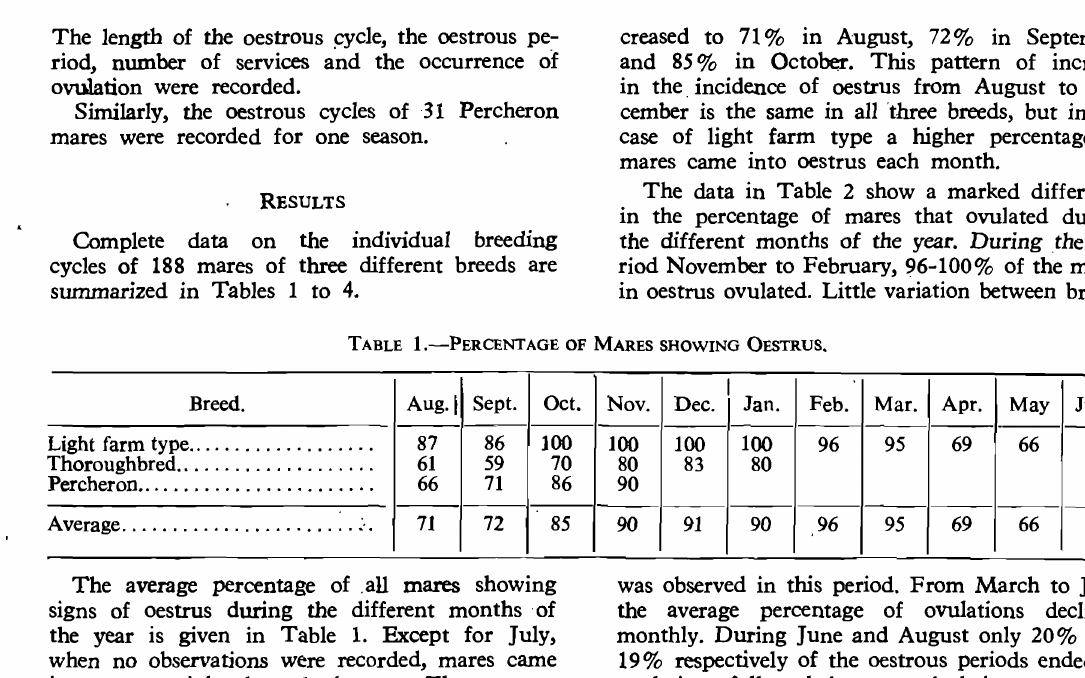
TABLE 2.-PERCENTAGE OF MARES IN OESTRUS THAT OVULATED. Breed